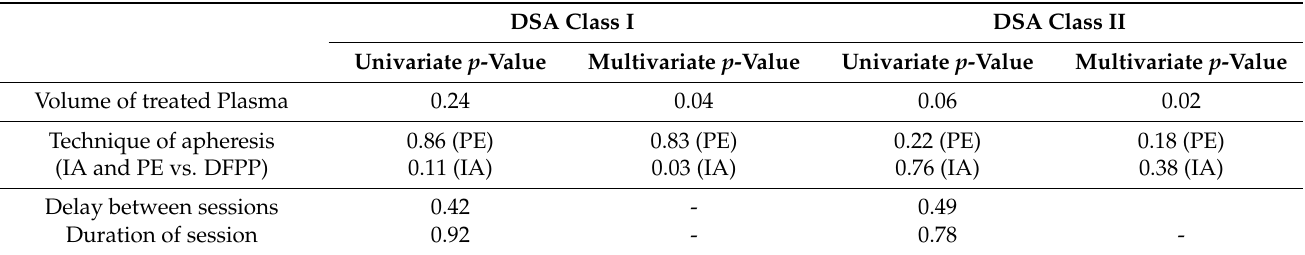
Table 4. Uni- and multivariate analyses of factors associated with reduction of inter-session MFI of immunodominant DSAs.